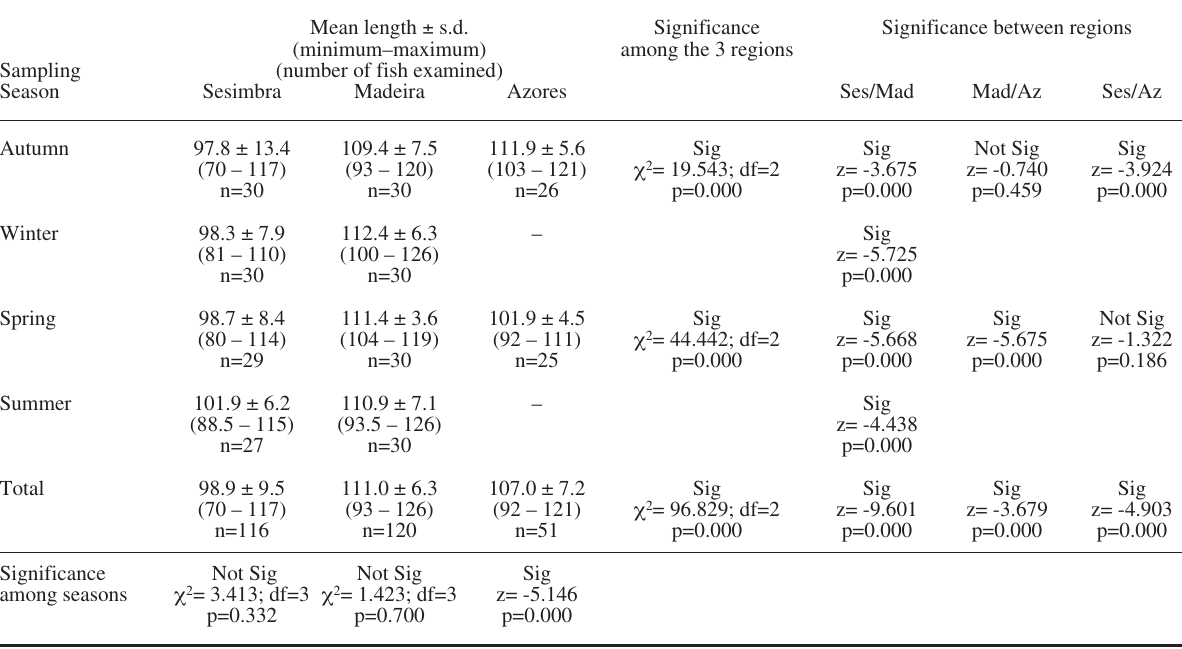
Table 1. – Fork length (cm) of Aphanopus carbo examined in the four year seasons: significance of length differences among regions and among seasons estimated by the kruskal-Wallis ( c 2 ; df; p) or Mann-Whitney (z; p) test (sig, significantly different). Mean length ± s.d.